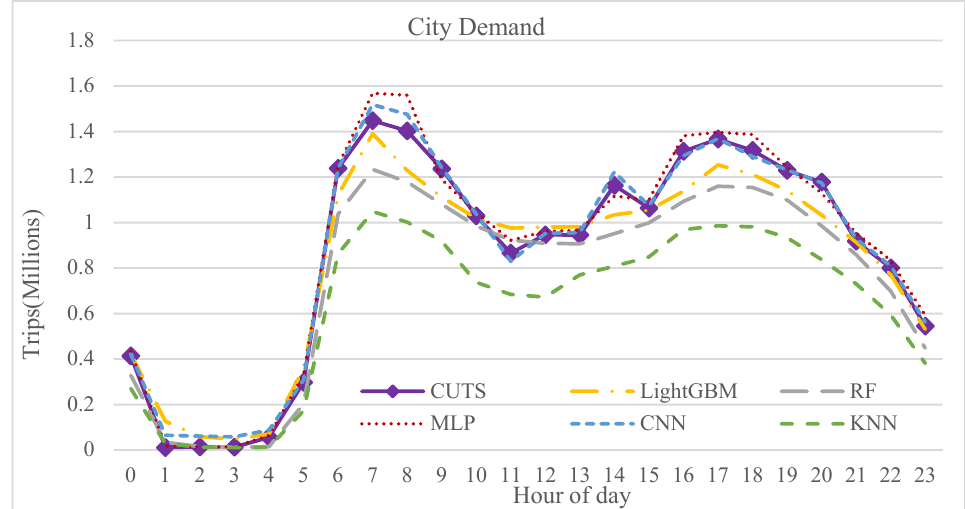
Figure 9. Comparison between developed models according to hourly distribution.